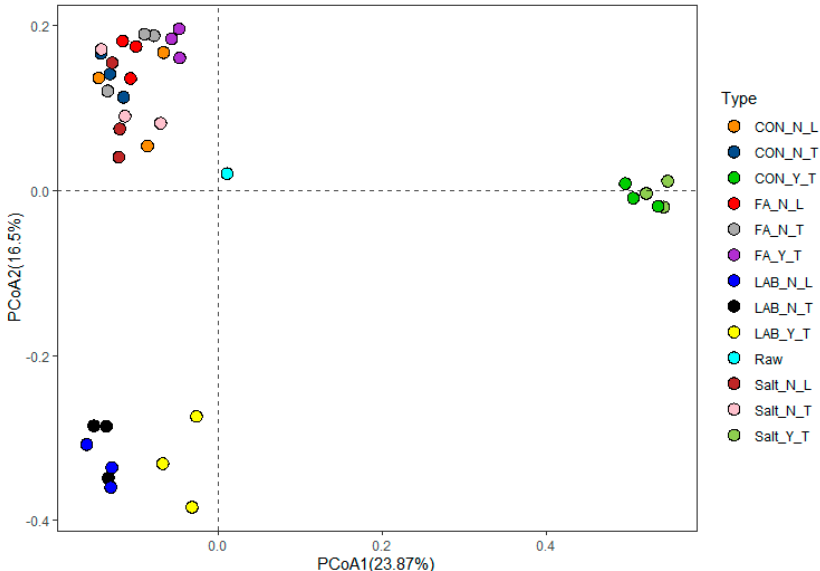
Figure 1. Beta diversity analysis of grass silage treated with different additives under two compaction and soil contamination levels. CON: Control, FA: Formic acid-based additive, LAB: Lactic acid bacteria additive, Salt: Salt based additive, N: non-contaminated, Y: contaminated, L: loose compaction, T: tight compaction, Raw: raw material before ensiling.